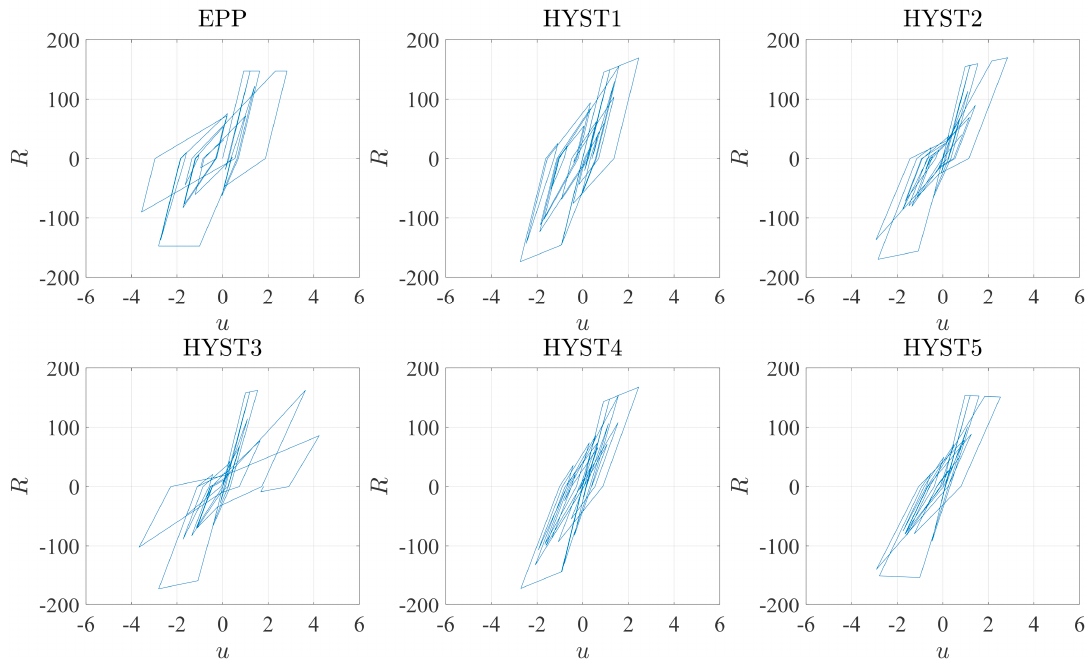
Figure 1. Displacement u —restoring force R response of the analyzed hysteretic single-degree-of-freedom (SDOF) systems (Table 1) for the considered set of model parameter values (Table 2).